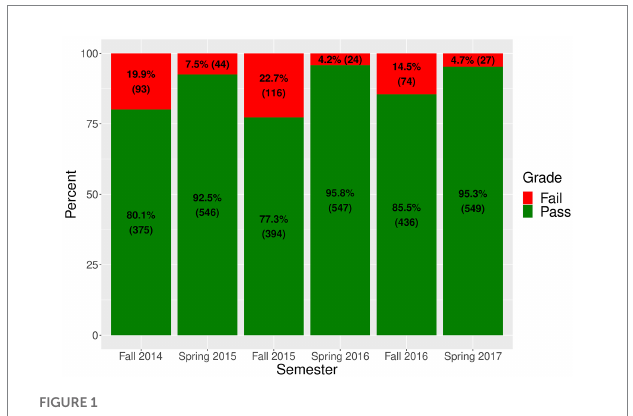
FIGURE 1 Course grade information by semester